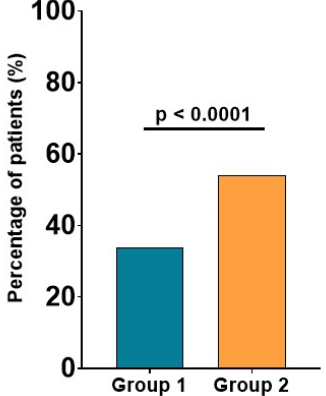
Figure 2. Significant carotid plaques in patients with low versus high Apo B. The values are expressed as percentages; p -values refer to between-group comparisons based on a chi-squared test.